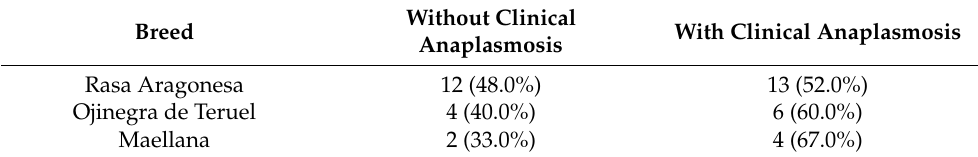
Table 3. Relationship between clinical signs of anaplasmosis and the breed reared on the farm.